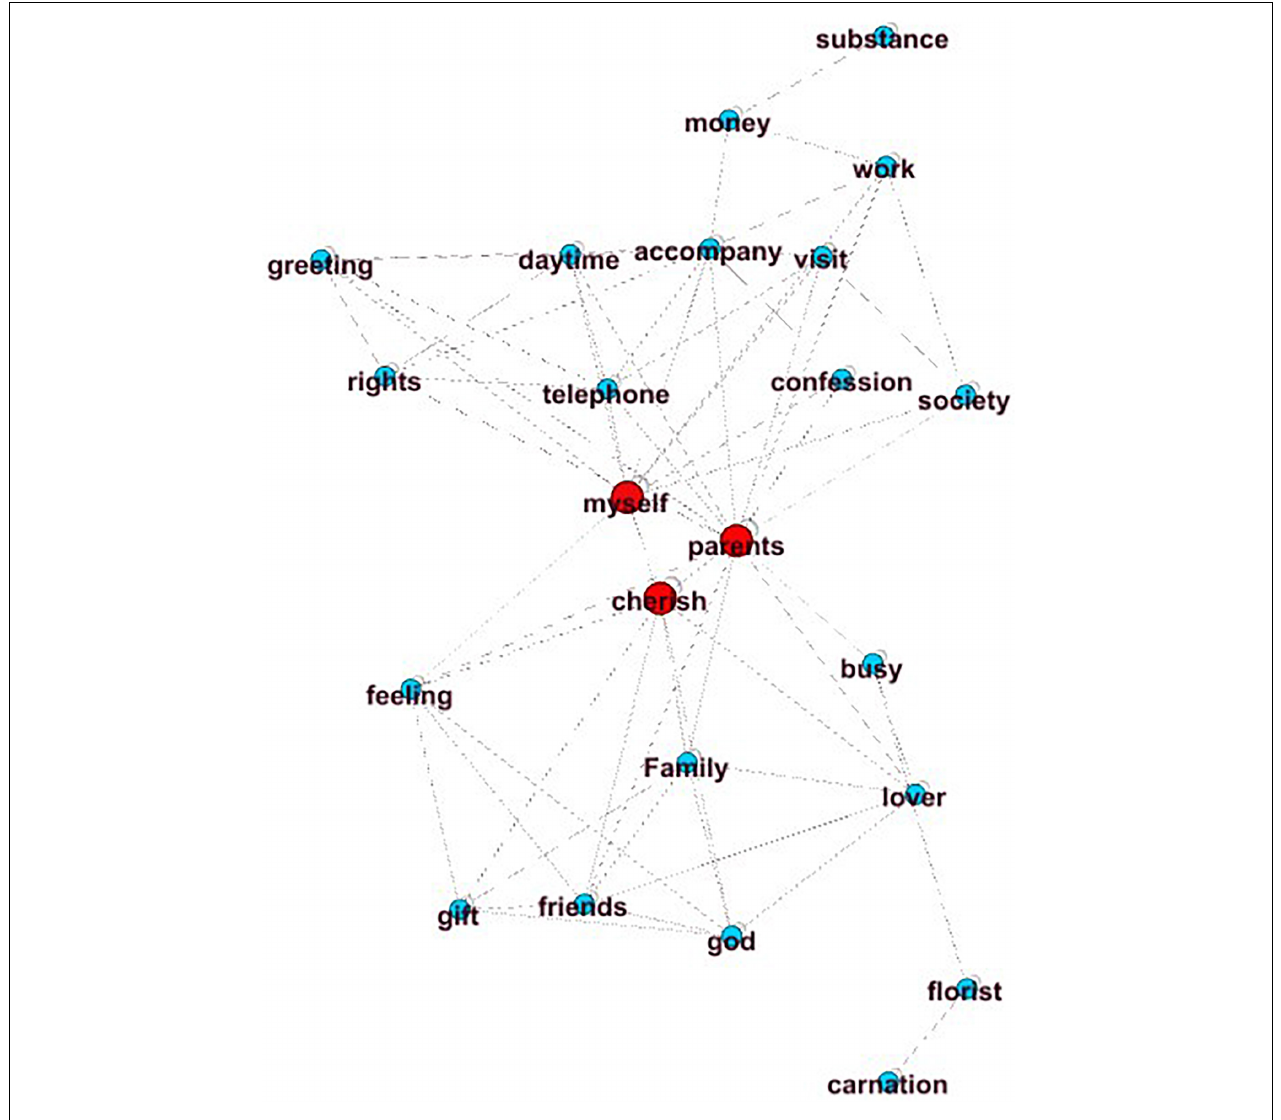
FIGURE 6 | High-level